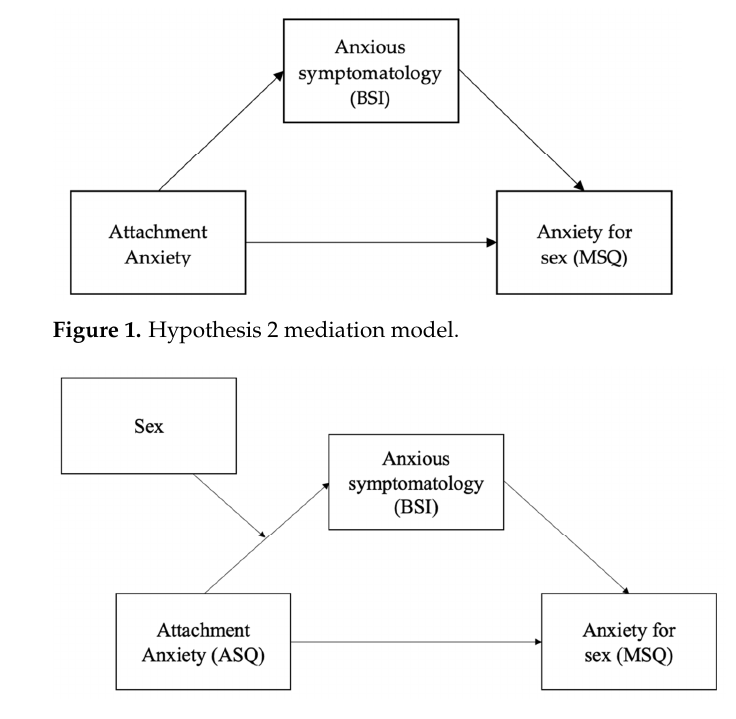
Figure 2. Hypothesis 3 moderated mediation model.